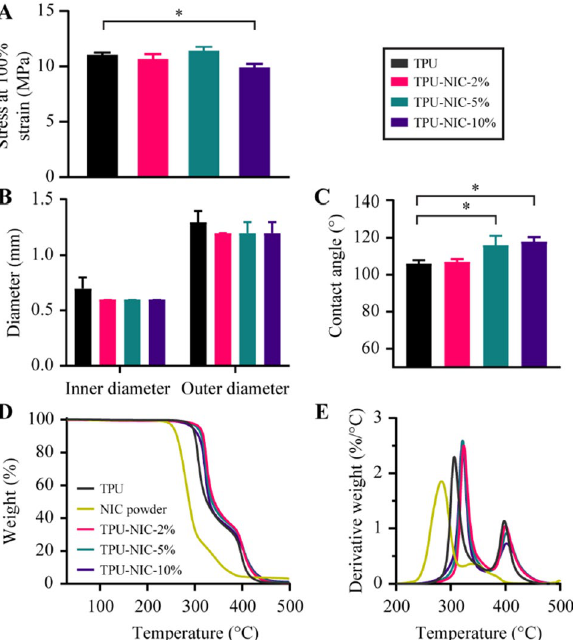
Figure 3. ( A ) Stress at 100% strain for produced TPU and NIC loaded TPU fibers ( n = 5), ( B ) Inner and outer diameter of produced TPU tubes ( n = 6), ( C ) Water contact angle measurements of produced TPU catheters ( n = 10). ( D ) Percentage weight loss vs. temperature and ( E ) Derivative of percentage weight loss vs. temperature in produced TPU fibers. * Indicates a p -value of 0.01 to 0.05.